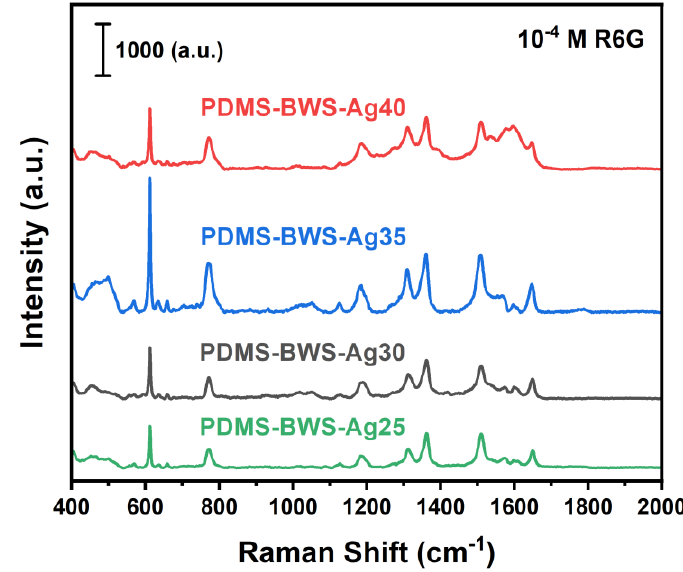
Figure 4. SERS spectra of rhodamine 6G (R6G) molecules (10 −4 M) measured by PDMS-BWS-Ag25, PDMS-BWS-Ag30, PDMS-BWS-Ag35, and PDMS-BWS-Ag40 SERS substrates.